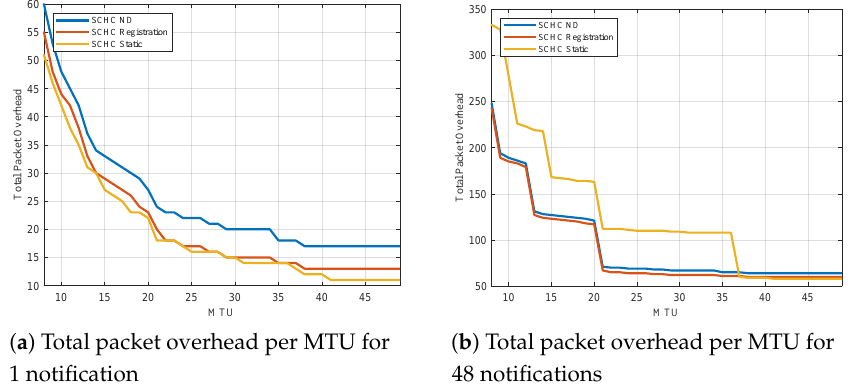
Figure 19. The total packet overhead for the complete LwM2M registration flow and different number of observation notifications.